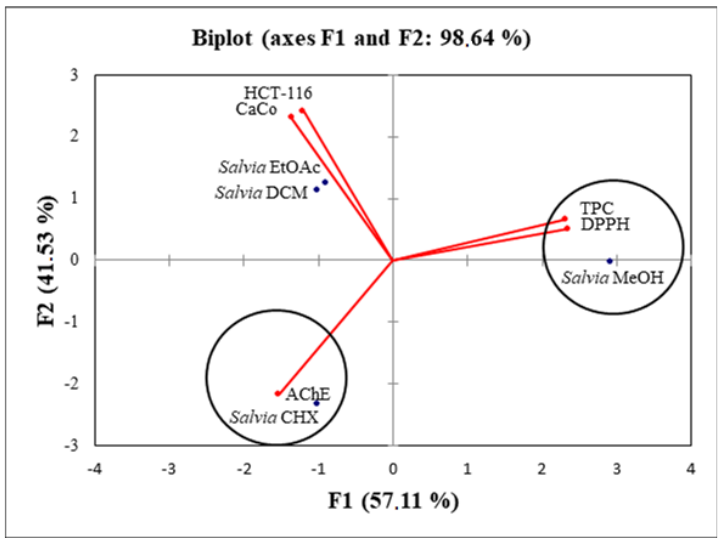
Figure 4. Principal component analysis biplot of the antioxidant and biological activities of the S. fruticosa extracts.